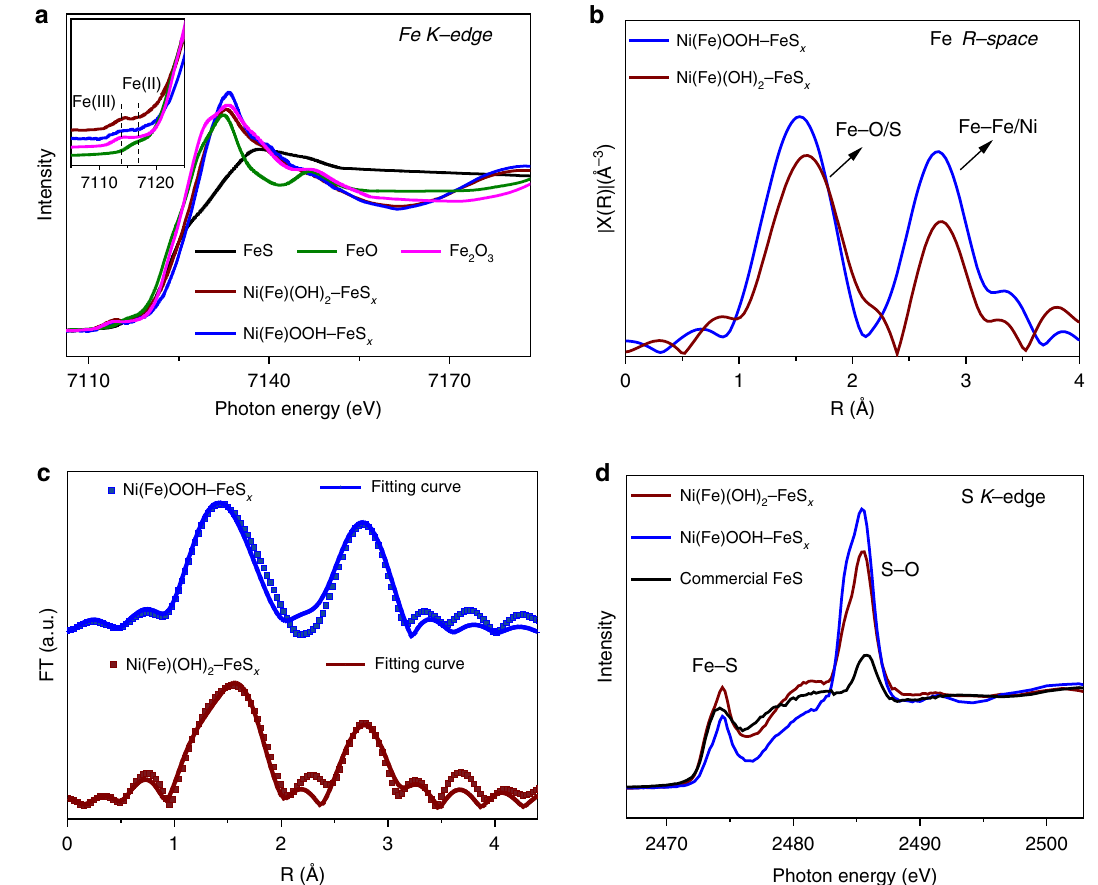
Fig. 4 XANES and EXAFS analysis of Ni(Fe)(OH) 2 – FeS x and Ni(Fe)OOH – FeS x . a Fe K -edge XANES spectra (inset shows the enlarged edge area), b Fe R - space EXAFS spectra, c the associated Fourier transforms and fi tting curves of Fe K -edge EXAFS spectra, and d S K -edge XANES spectra.